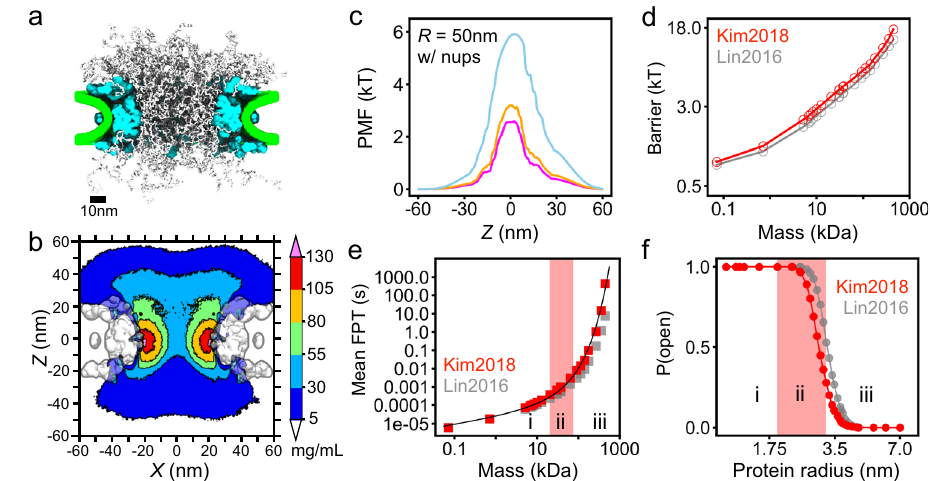
Fig. 6 | Passive diffusion of proteins through yeast NPC. a Representative con- fi gurationoftheCGmodeloftheintegrativeKim2018structureofyeastNPC 55 .The FG-nups are shown in white, protein scaffold in cyan and lipid bilayer in green. b Cross-sectionoftheaverageFG-nupamino-aciddensity.The3Ddensitymapwas generated by averaging instantaneous con fi gurations of the Kim2018 computa- tionalmodelevery0.1 μ soverthe fi nal6msfragmentofthe7.5mssimulation.The cross-sectionwasaveragedalongthe y coordinatewithinthe( − 7.5,+7.5)nmrange. c PotentialsofmeanforcealongtheporeaxisoftheKim2018model,calculatedby voidanalysisforproberadiiof12.75,15.71,and30.04 Å (magenta,orange,andlight blue, respectively). d PMF barrier as a function of protein mass, calculated by void